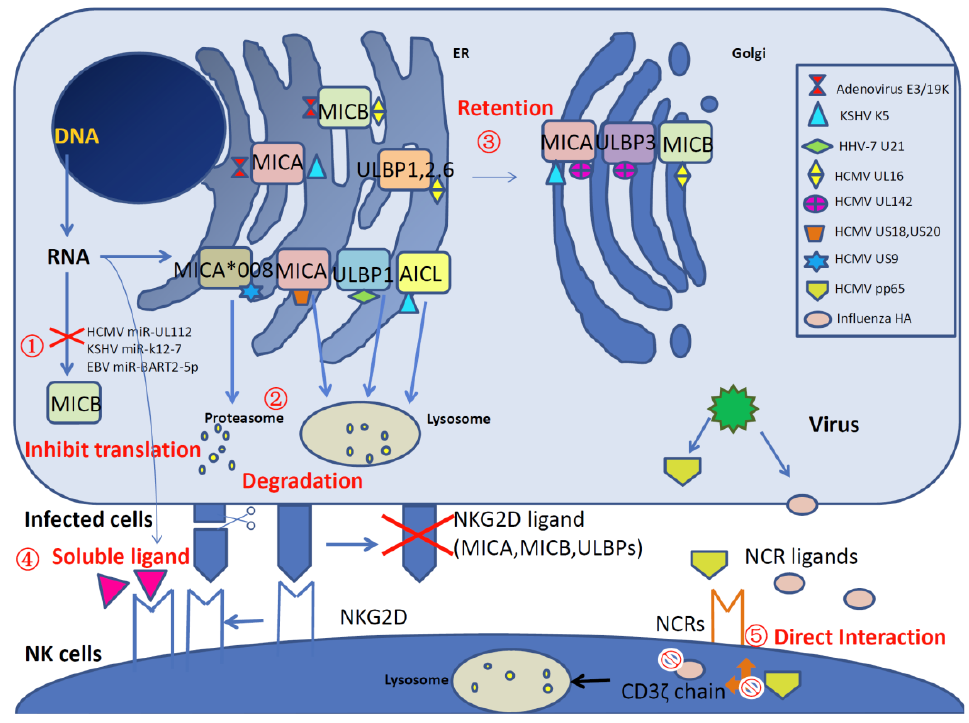
Figure 1. A schematic overview of viral interference with natural killer (NK) cell-activating receptors and ligands. A variety of viral products disrupt NK cell activation by impairing the natural killer group 2 member D (NKG2D) receptors and natural cytotoxicity receptors (NCRs) (NKp30, NKp44 and NKp46) and their ligands (major histocompatibility complex (MHC) class I-related chain A (MICA), MHC class I-related chain B (MICB) and UL16 binding proteins (ULBPs)) at different levels, as described below. 1 (cid:13) miRNA-related ligand inhibition. Human cytomegalovirus (HCMV) miR-UL112, Kaposi’s sarcoma-associated herpesvirus (KSHV) miR-K12-7 and Epstein–Barr virus (EBV) miR-BART2-5p specifically inhibit MICB translation. 2 (cid:13) Degradation of NKG2D ligands. KSHV K5 downregulates the cell surface expression of MICA and the NKp80 ligand activation-induced C-type lectin (AICL). HCMV proteins US18, US20 and HHV-7 protein U21 reduce the level of MICA by lysosomal degradation. Additionally, HCMV US9 targets MICA*008 for proteasomal degradation. 3 (cid:13) Retention of NKG2D ligands inside cells. Adenovirus E3/19K retains MICA and MICB in the endoplasmic reticulum (ER), HCMV UL142 downregulates MICA and ULBP3 by increasing retention in the cis -Golgi apparatus. Additionally, HCMV UL16 retains MICB, ULBP1, ULBP2 and ULBP6 in ER/ cis -Golgi via direct interaction. 4 (cid:13) Competitive binding with NKG2D by soluble ligands. Orthopoxvirus MHC class I-like